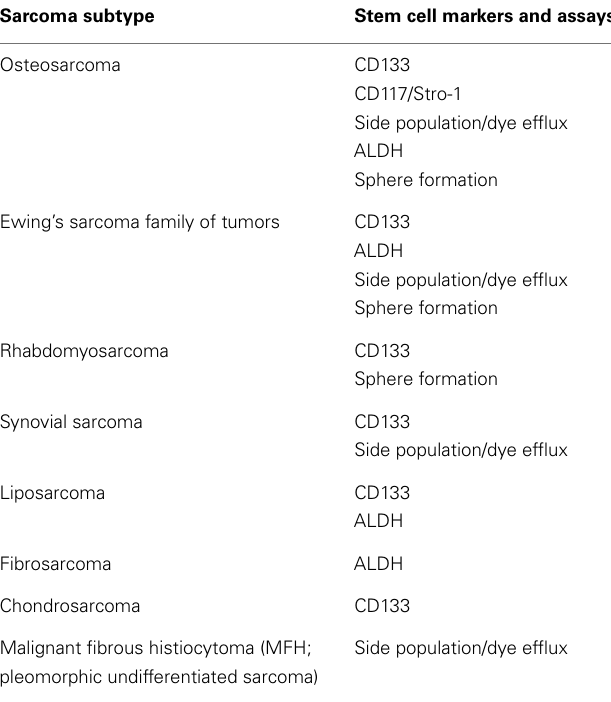
Table 1 | Methodologies for characterizing sarcoma stem